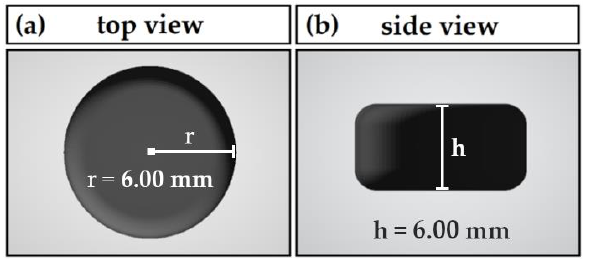
Figure 1. Dimensions and appearance of biplane tablet printlet: ( a ) top view; ( b ) side view.